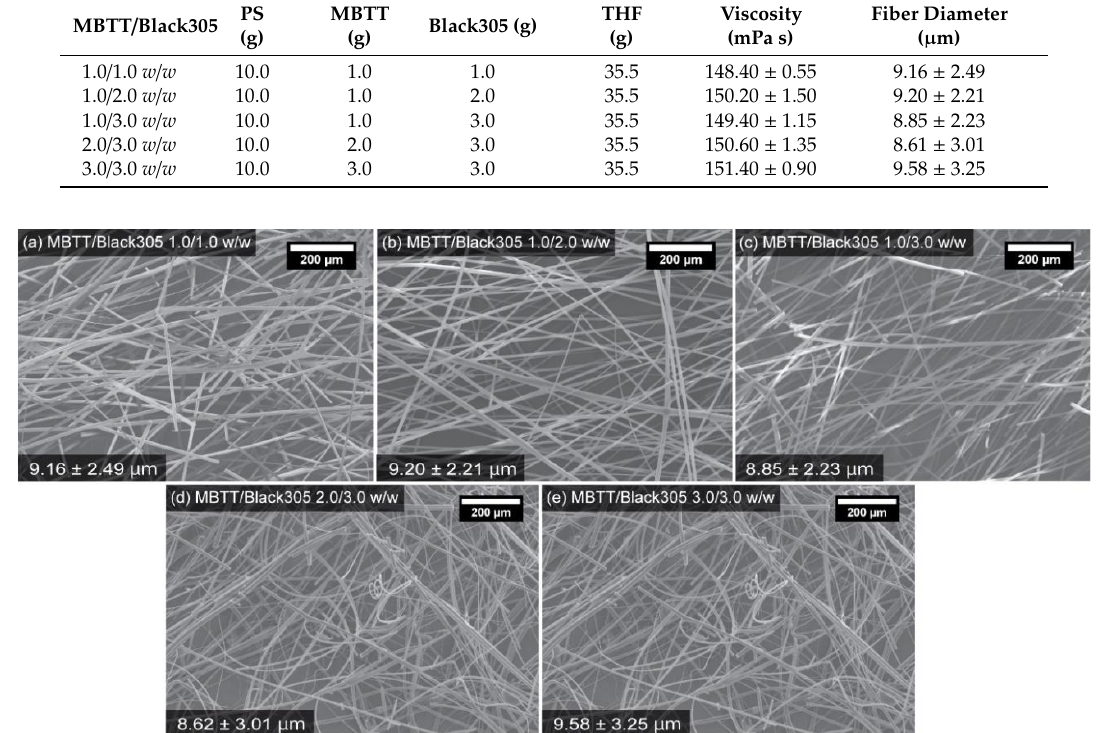
Figure 1. SEM images for the fibrous color dosimeters using the composite fibers prepared using the conditions specified in Table 1.